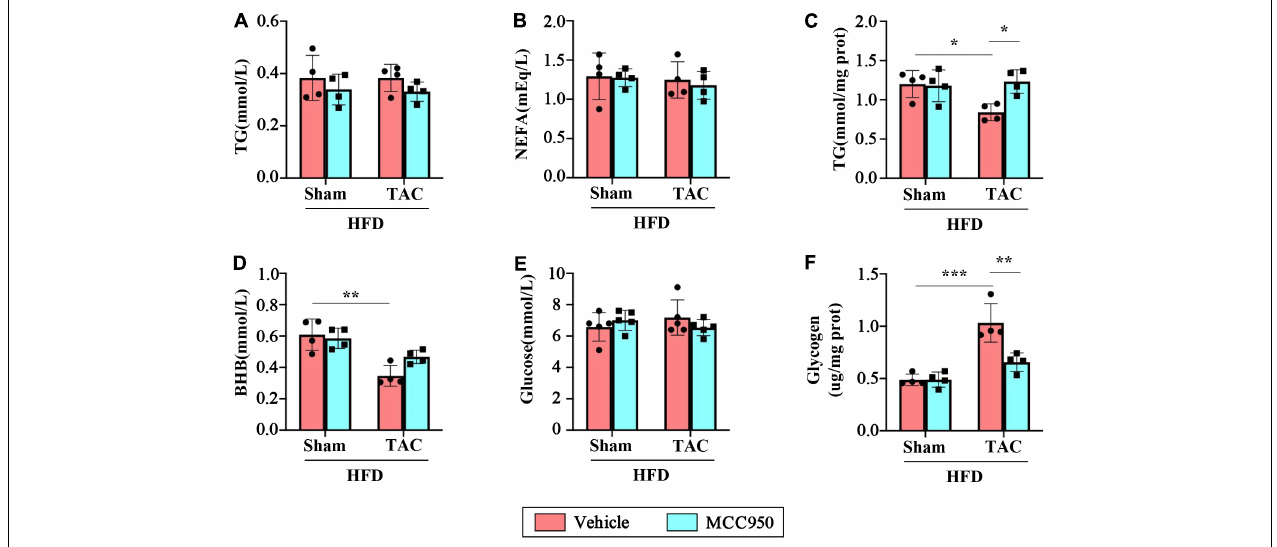
FIGURE 5 | MCC950 reduced the metabolic reliance on glucose in TAC hearts. Serum levels of TG (A) and NEFA (B) , n = 4. (C) Level of TG in the cardiac, n = 4. Serum levels of BHB (D) and glucose (E) , n = 4. (F) glycogen levels in the cardiac, n = 4. TG, triglyceride; NEFA, non-esterified fatty acids; BHB, β